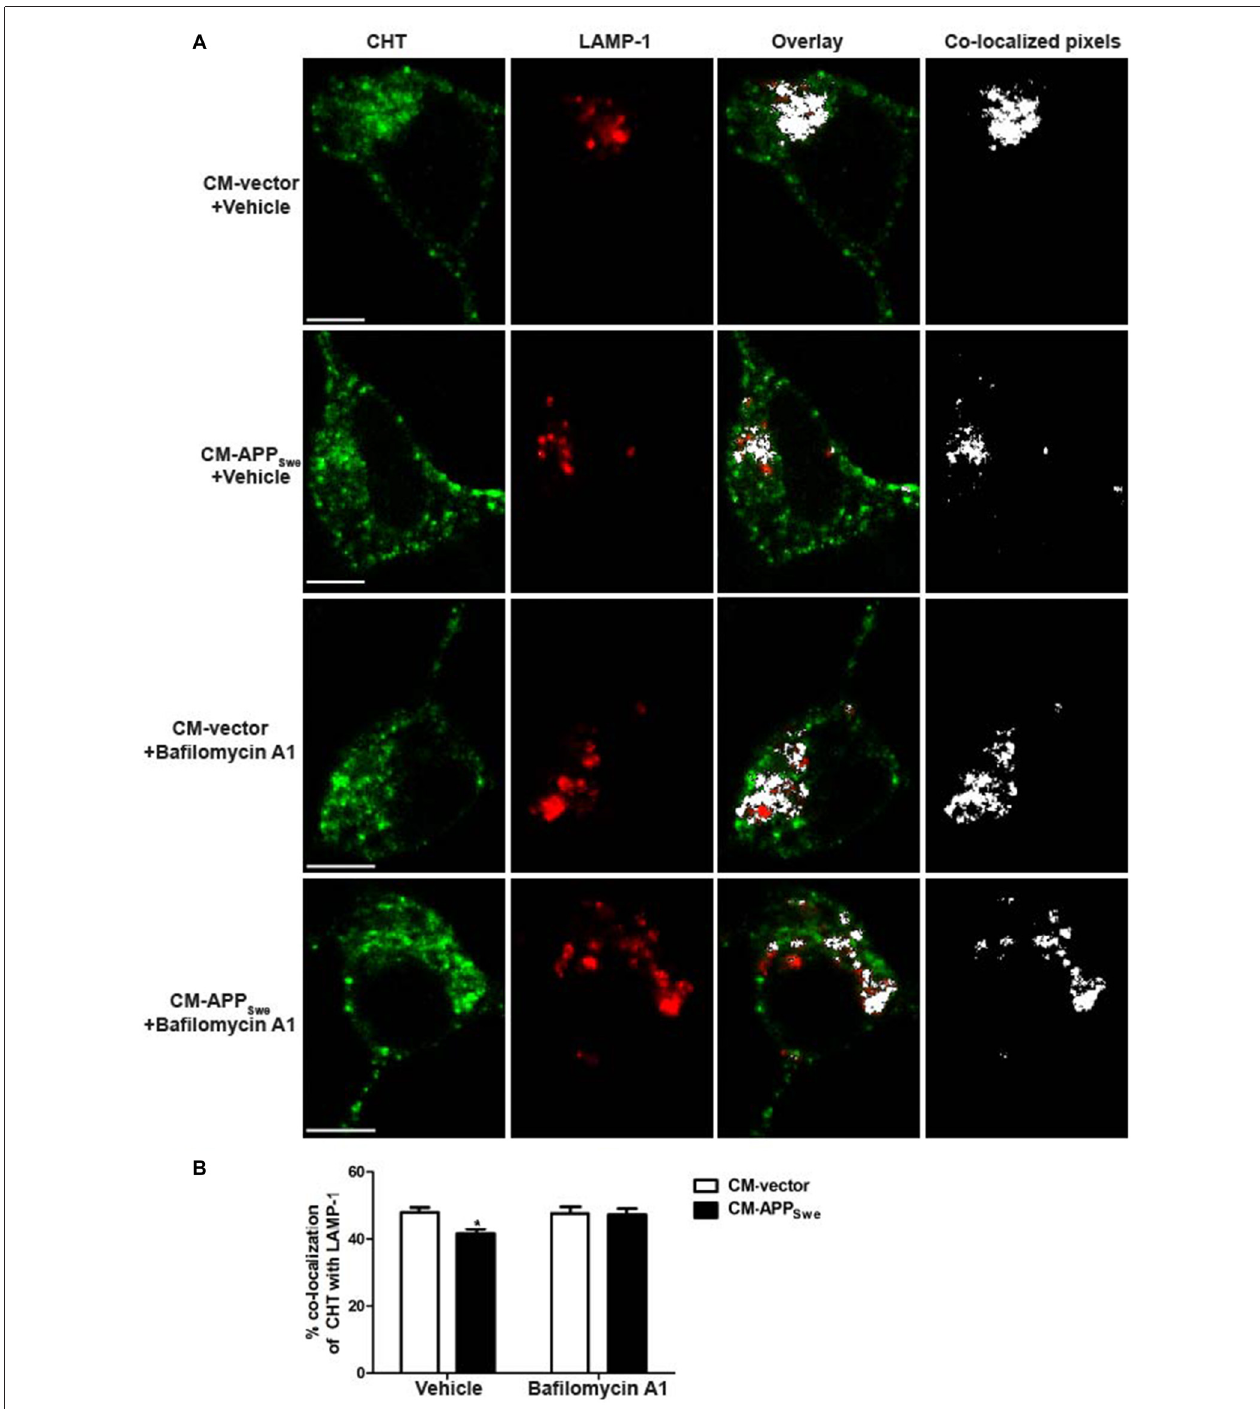
FIGURE 6 | Subcellular distribution of CHT with lysosome marker LAMP-1 in SY5Y-CHT cells treated with CM derived from SY5Y-CHT cells expressing APP Swe containing bafilomycin A1 (BafA 1 ). (A) CM was collected from SY5Y-CHT cells that had been transiently expressing either vector or APP Swe plasmid DNA for 24 h (CM-vector and CM-APP Swe , respectively). CM-vector and CM-APP Swe containing either vehicle (DMSO) or 20 nM BafA 1 were added to SY5Y-CHT cells for 24 h and then cells were formalin-fixed. Confocal images show the distribution of AlexaFluor 647-labeled CHT (green) and AlexaFluor 488-labeled LAMP-1 (red). Co-localized pixels were identified in the co-localization channel and are shown as white in the right co-localized pixels panels. Scale bars, 5 µ M. (B) CHT and LAMP-1 pixels that were determined to be co-localized in the co-localization channel were quantified using Imaris software. Data are expressed as the mean ± SEM for a minimum of 15 cells per transfection group from four independent experiments, and were analyzed by two-way ANOVA followed by Tukey’s post hoc multiple comparisons test ( ∗ p ≤ 0.05).